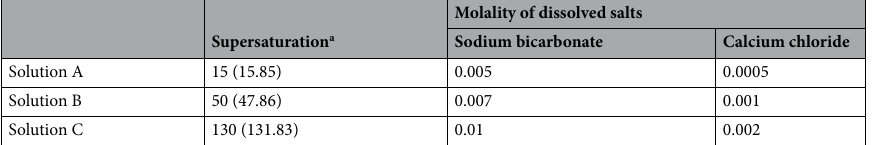
Table 1. Supersaturation and molality of stock solutions prepared for calcium carbonate synthesis experiments. a Ω = Q/K , where Q is the ion activity product and K the equilibrium constant for the